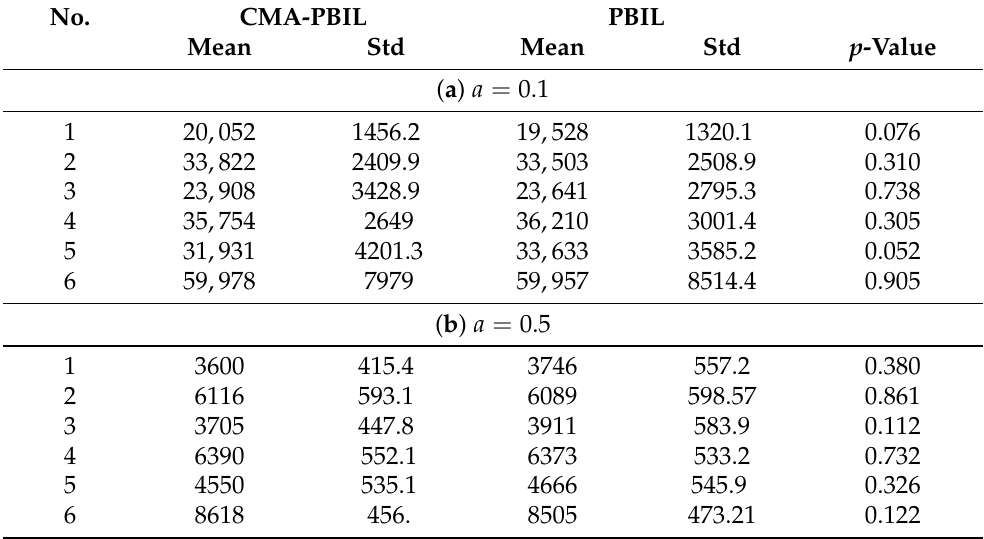
Table 4. Comparison of the average number of objective function evaluation and its standard deviation for each test